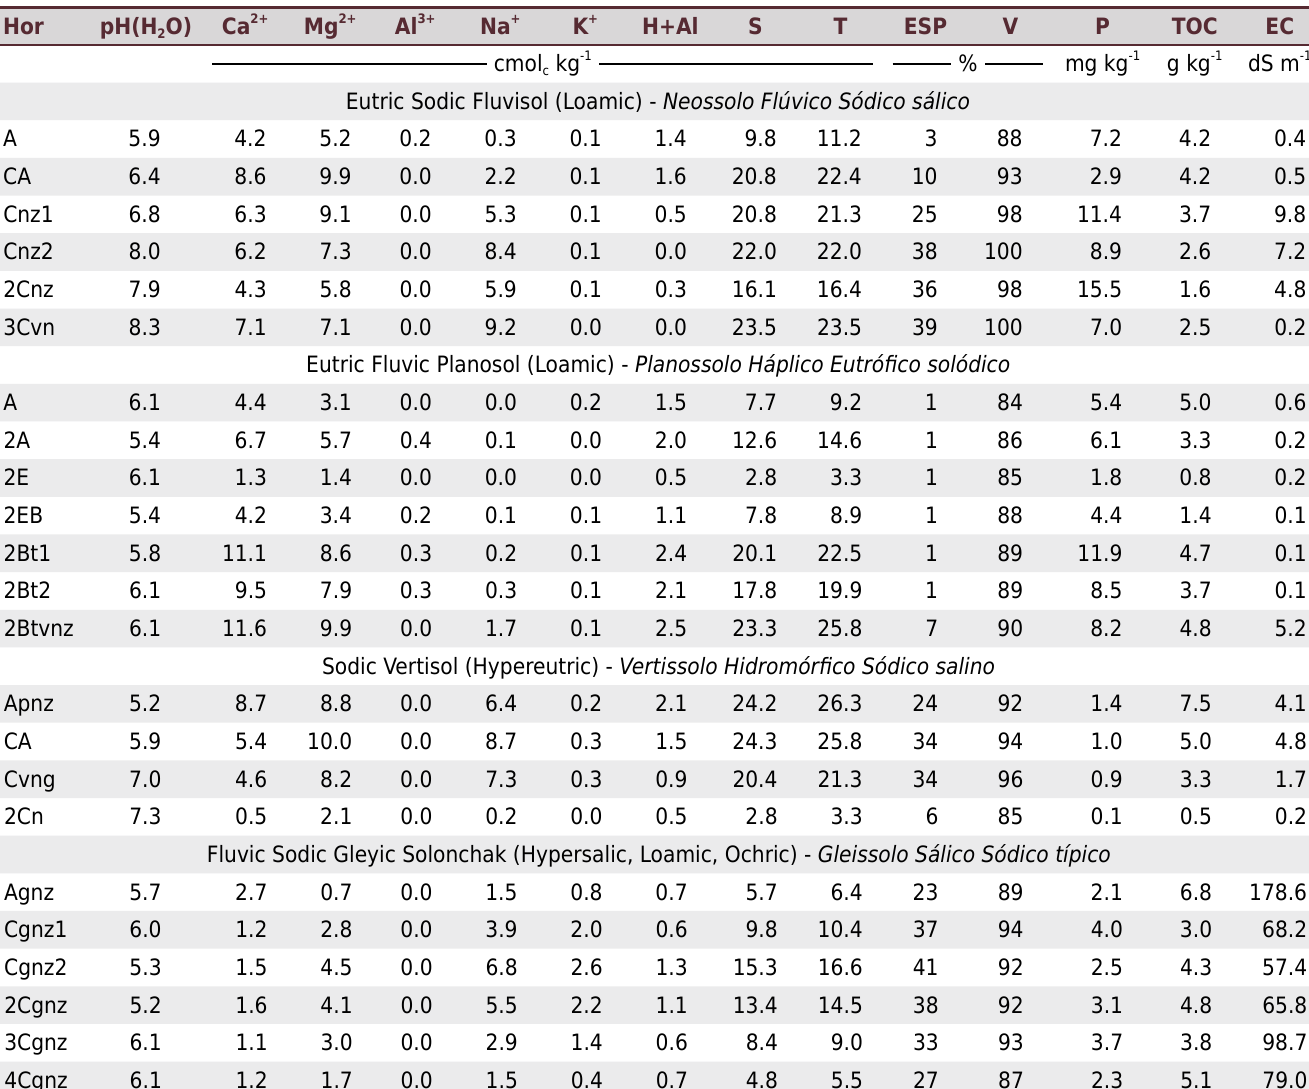
Table 4. Chemical attributes of soil profiles localized in lower course of the Acaraú River (Ceará State, Brazil) Hor pH(H 2 O) Ca 2+ Mg 2+ Al 3+ Na +